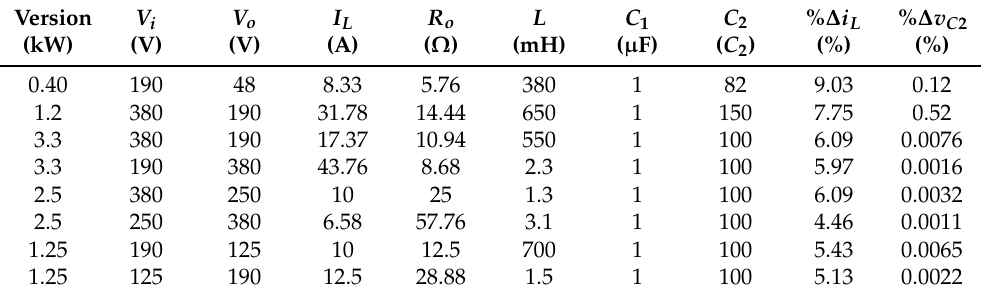
Table 5. Parameter design values for all the versions of DC–DC full bridge converter.